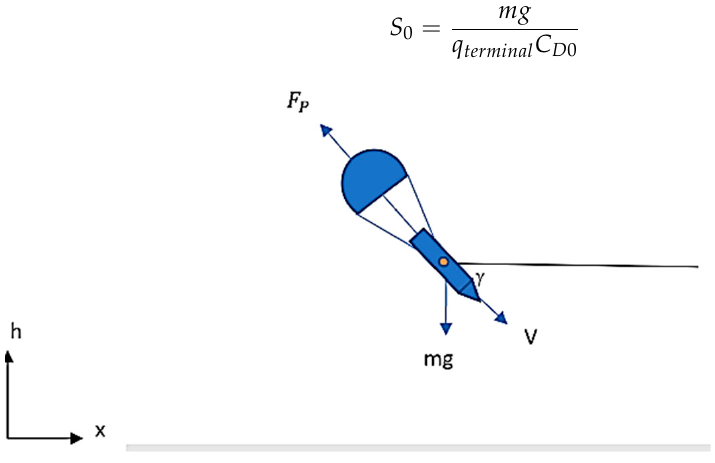
Figure 5. Diagram of parachute model dynamics.